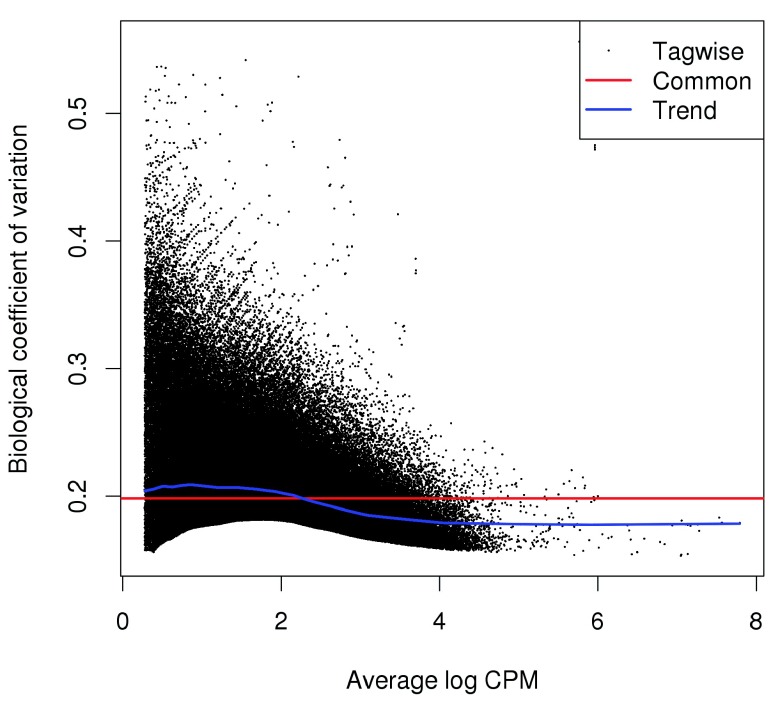
Abundance-dependent trend in the BCV for each window, represented by the blue line.Common (red) and tagwise estimates (black) are also shown.